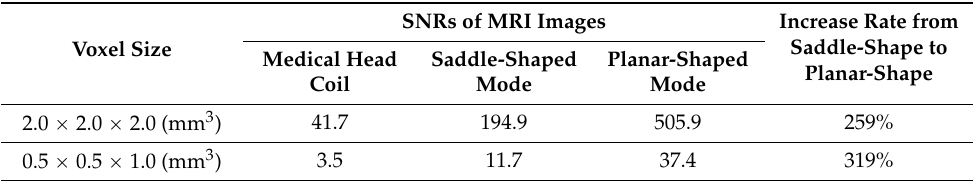
Saddle-Shape to Saddle-Shape to Planar-Shape